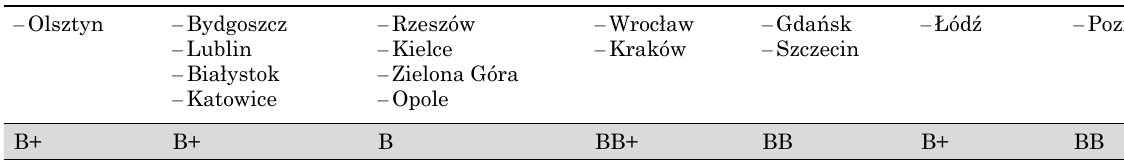
“Approximate” real estate markets according to demand indicators